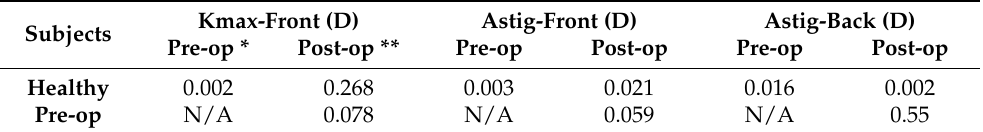
Table 3. p ‐ values for the comparison of Kmax ‐ front, and the astigmatism of the anterior (Astig ‐ Table 3. p -values for the comparison of Kmax-front, and the astigmatism of the anterior (Astig-front) front) and the posterior (Astig ‐ back) corneal surfaces of the healthy controls and the patients (mean and the posterior (Astig-back) corneal surfaces of the healthy controls and the patients (mean ± sd) ± sd) obtained from Pentacam. obtained from Pentacam.